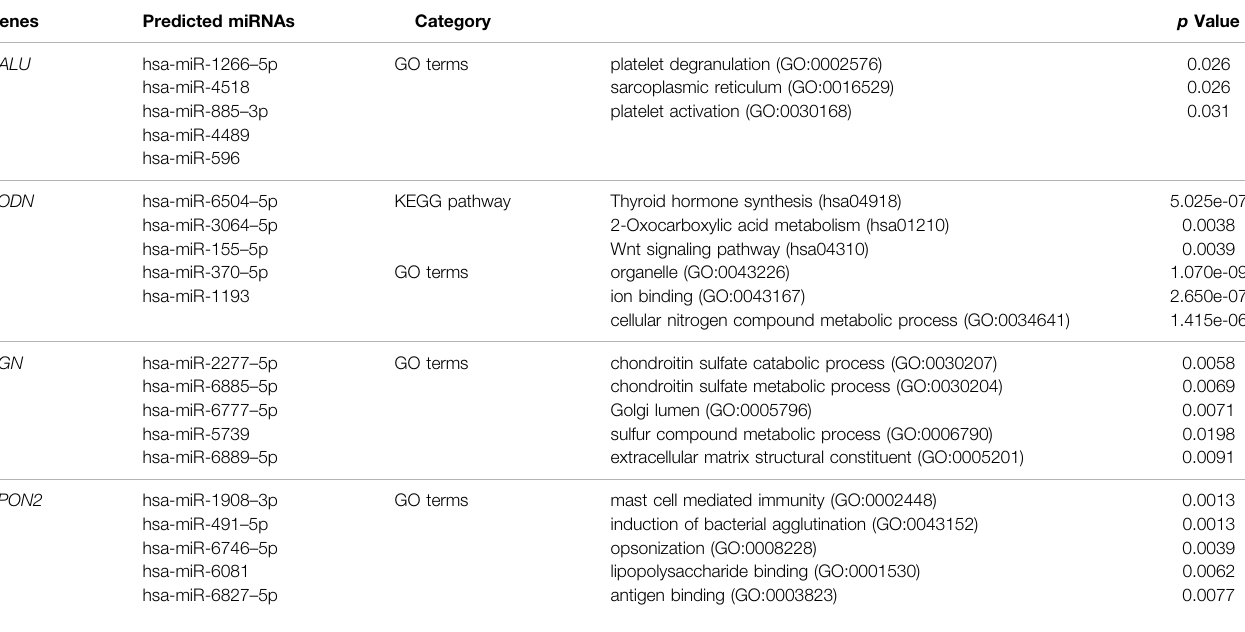
TABLE 4 | The Gene Ontology (GO) terms and Kyoto Encyclopedia of Genes and Genomes (KEGG) pathways enrichment among the four key genes.